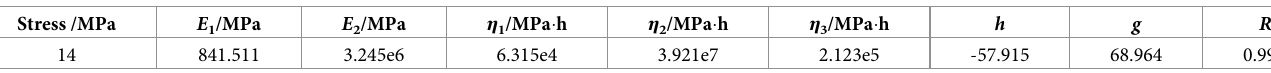
Table 4. Identification table of CF-D-NVP model parameter.